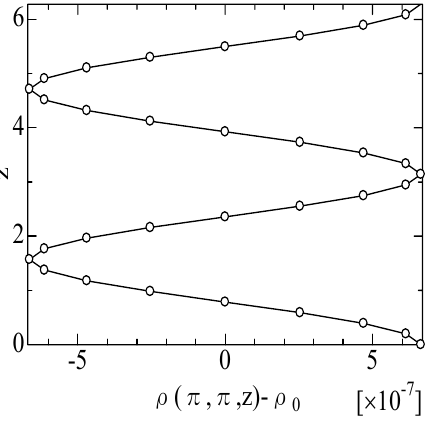
Fig. 5 Distribution of density at x = ( π , π ,z).